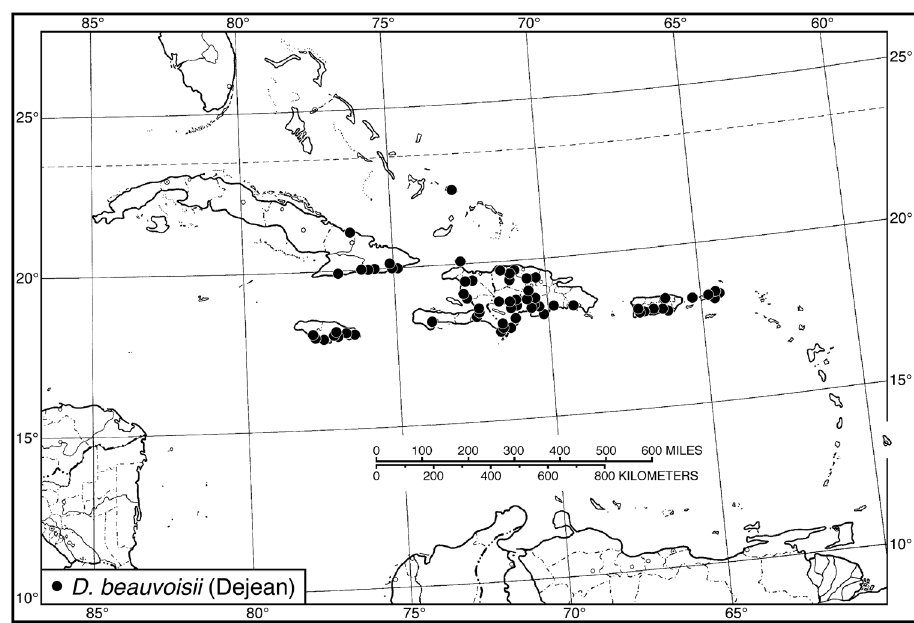
Figure 70. Map of West Indies showing known localities for species of Discoderus LeConte, in part.